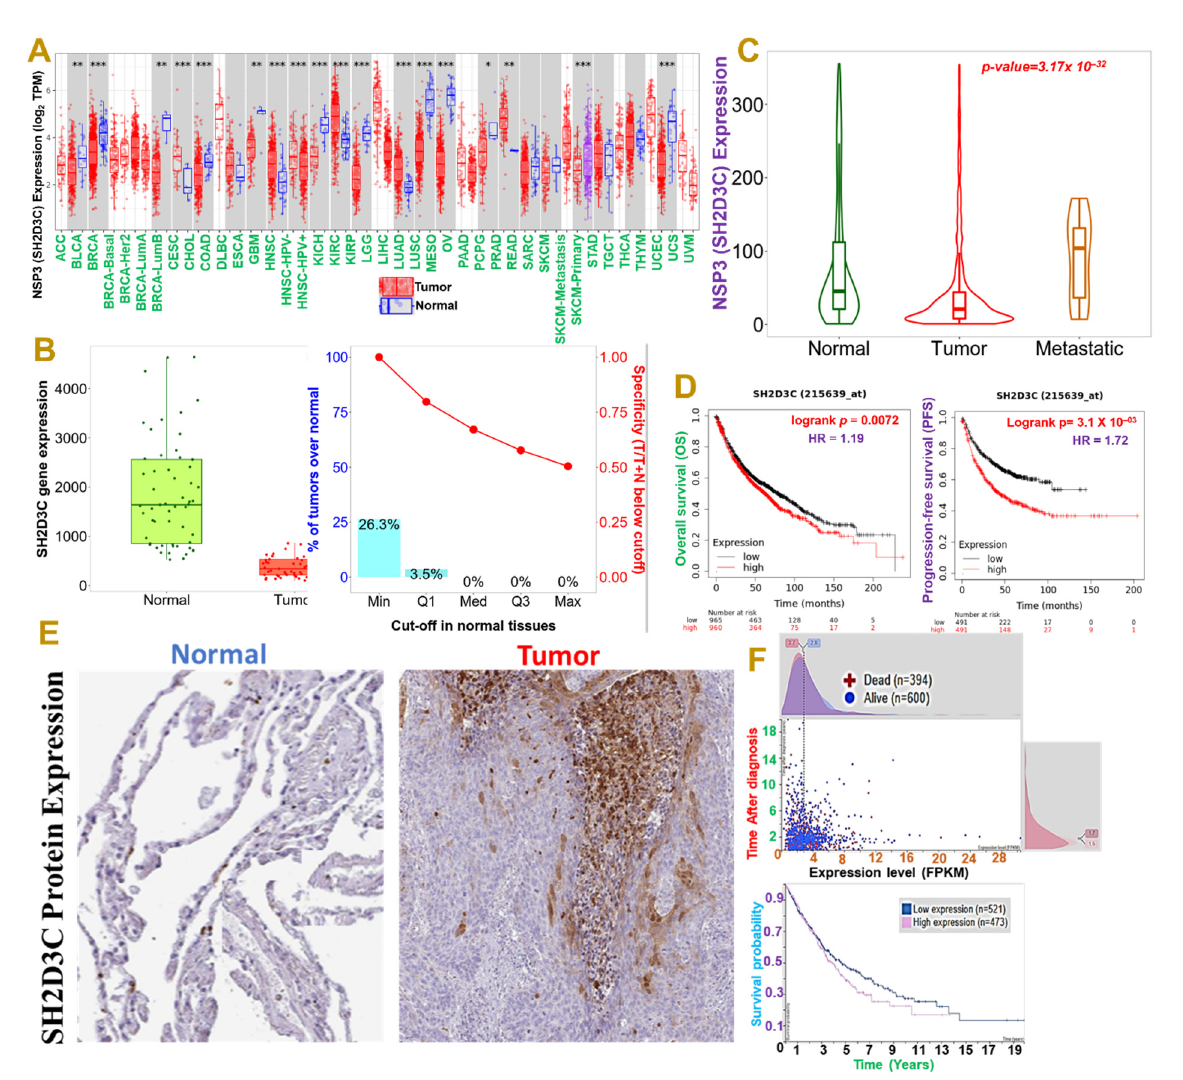
Figure 1. Non-structural protein 3 ( NSP3; SH2D3C ) is associated with advanced stages and poor prognoses of lung cancer cohorts. ( A ) Box plots showing differential expression profile of NSP3 (SH2D3C) between tumor and adjacent normal tissue across all TCGA cancer types and ( B ) between tumor and adjacent normal tissues in lung cancer cohort. ( C ) Violine plots showing differential expression profile of NSP3 (SH2D3C) between normal tissue, tumor, and metastatic lung cancer patients. ( D ) Kaplan–Meier plot of the overall and progressive-free survival between lung adenocarcinoma patients with low and high expression levels of NSP3 (SH2D3C ). ( E ) Representative immunohistochemistry staining of SH2D3C between lung cancer tumor and pathological free tissue in the Human Protein Atlas (HPA) database. ( F ) Interactive survival scatter plots and Kaplan–Meier plot of the survival probability between high and low mRNA expression levels in lung cancer cohorts. * p < 0.05; ** p < 0.01; *** p < 0.001.